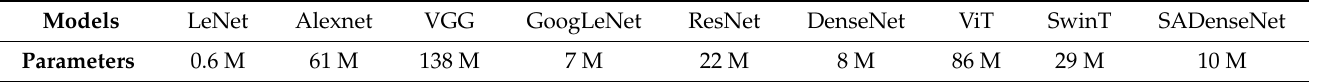
Table 7. Parameters of different classifiers based on deep learning.